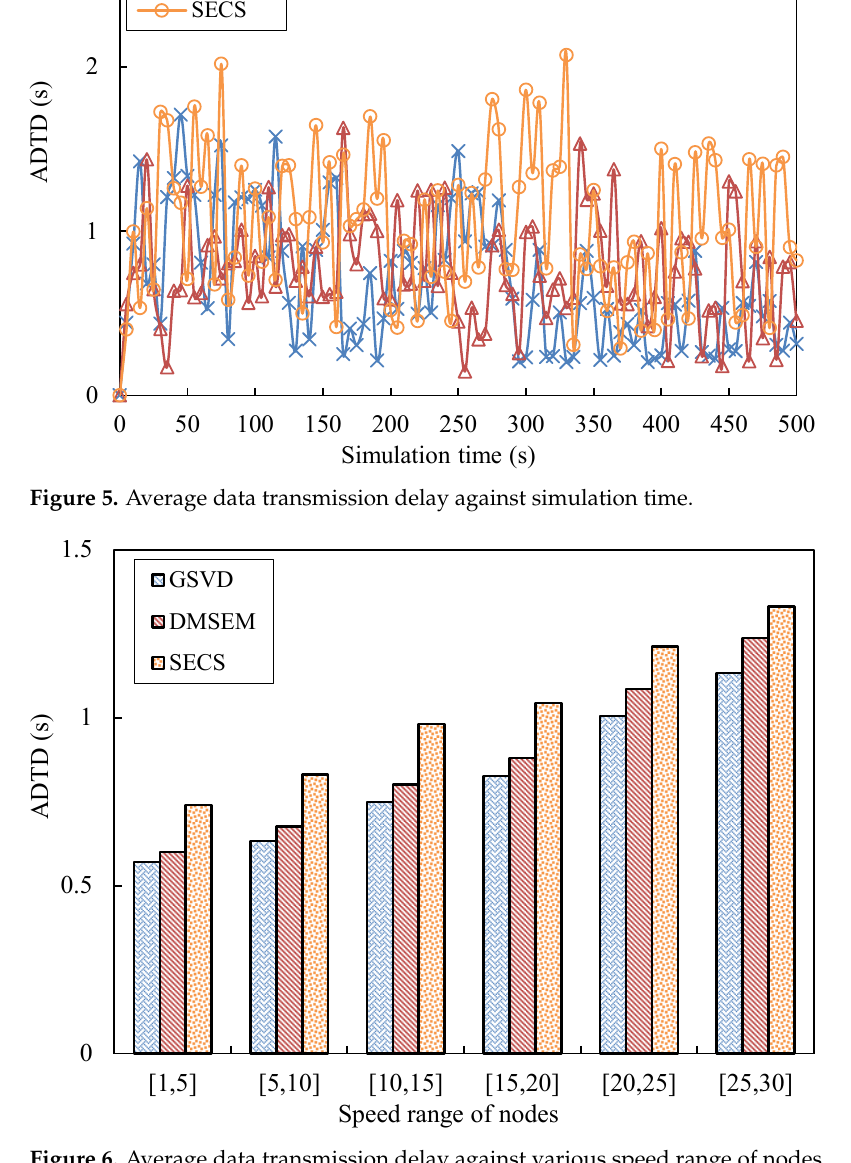
Figure 6. Average data transmission delay against various speed range of nodes. GSVD divides the urban area into multiple coded grids and makes use of the grid codes to express the geographical location of the mobile nodes. GSVD depends on the code-based geographical location to calculate the geographical distance between the